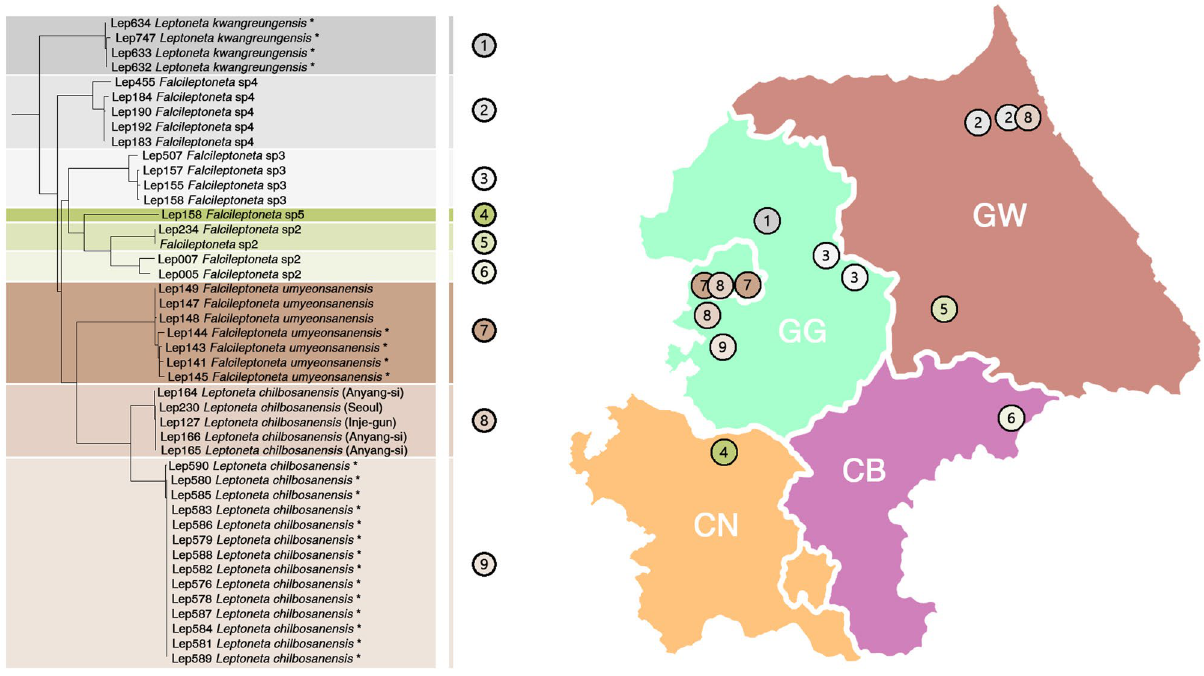
Figure 9. Intraclade sympatry occurring in central region of Korean peninsula. The map was prepared using QGIS 3.22.1 (https:// www. qgis. org/ ko/